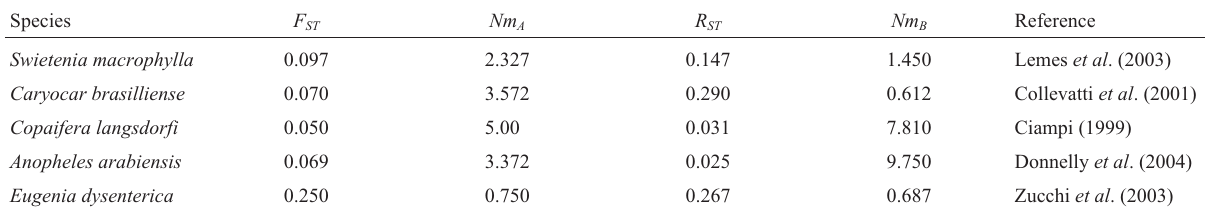
Table 1 - Microsatellite F ST , R ST and gene flow estimates calculated for populations of some tropical species. Note that Nm A was based on F ST while Nm B was calculated from R ST . Species F ST Nm A R